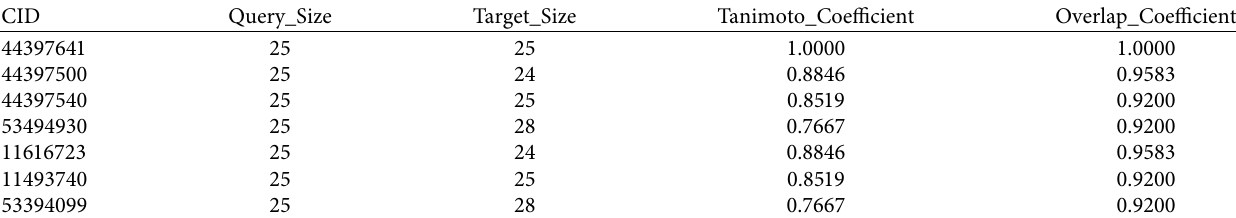
Table 5: Similarity measures for the molecule CID 44397641 and the molecules in Group 2.